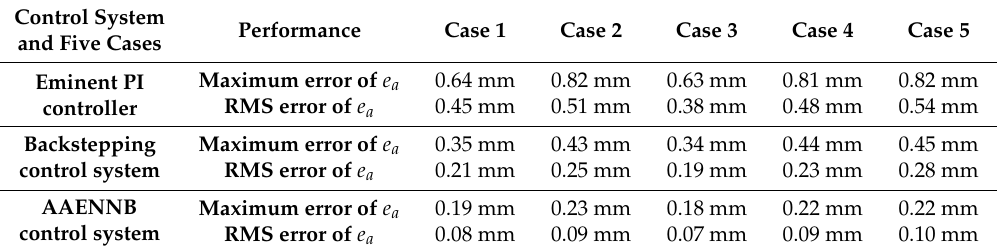
Table 1. Performance comparison of control systems.